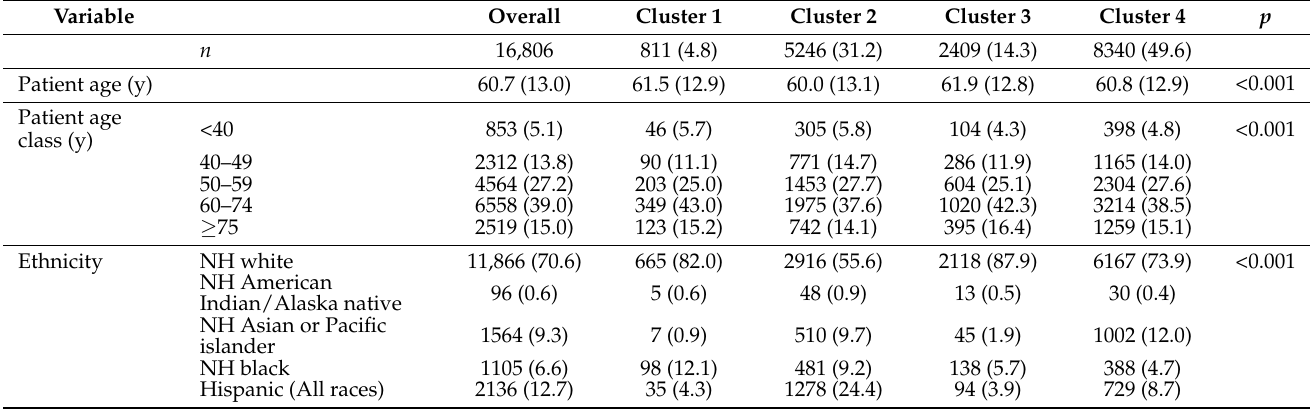
Table 1. Patient